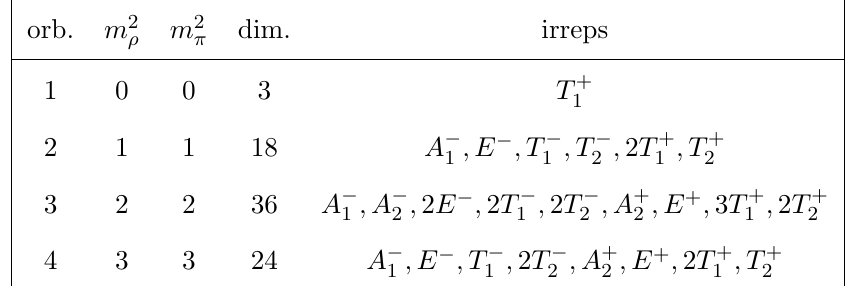
Table 6 . Cubic-group irreps contained in (cid:26)(cid:25) states. The intrinsic negative parity of the pion and the rho are included. Orbits are numbered, and speci(cid:12)ed by the squares of the momenta, with p = 2 (cid:25) m (cid:26) =L and p = 2 (cid:25) m (cid:25) =L . The irreps shown are present for each the three allowed isospins, (cid:26) (cid:25) I (cid:26)(cid:25) = 0, 1, and 2. The dimensions of the orbits apply separately for each choice of isospin.